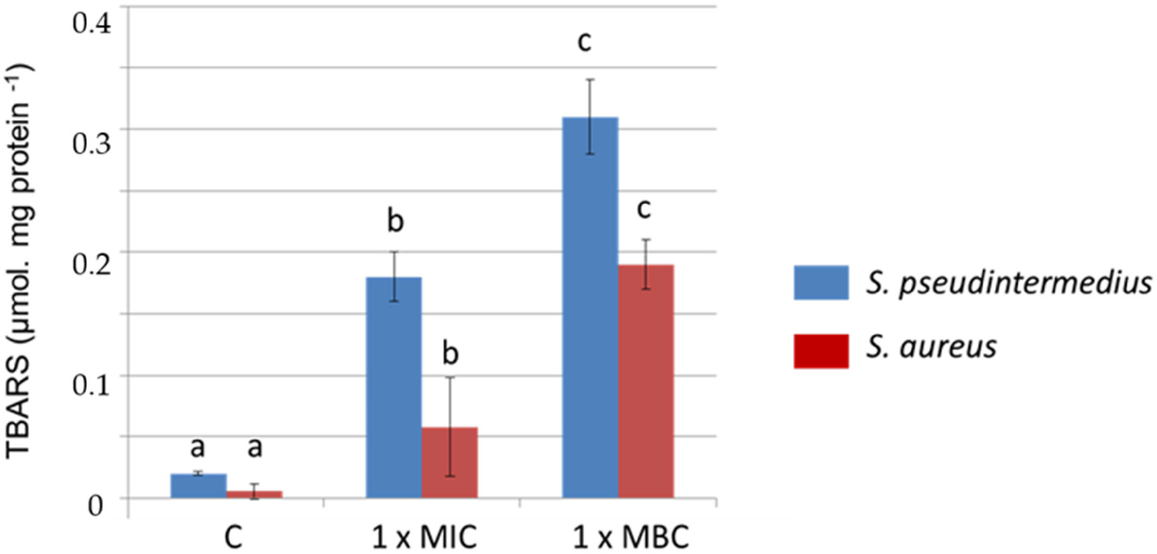
Figure 3. Levels of thiobarboturic acid reactive substances (TBARS) in cells of S. pseudintermedius and S. aureus treated with DHAB for 24 h at two different doses: MIC and MCB. C: control cells grown in TSB. Data are means of three determinations in two independent cultures, and significant differences at p < 0.05 are indicated by different letters; (a) correspond to the level of MDA in the strains cultivated in the absence of DHAB; (b, c) indicate significant differences in the presence of DHAB.